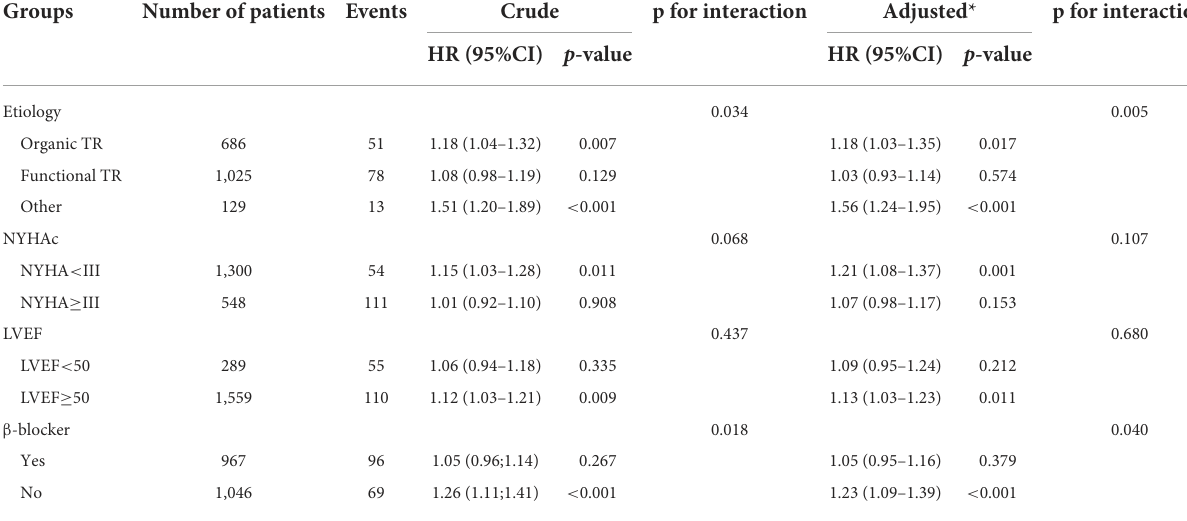
TABLE 6 Subgroup analyses of RHR in Clinically Meaningful